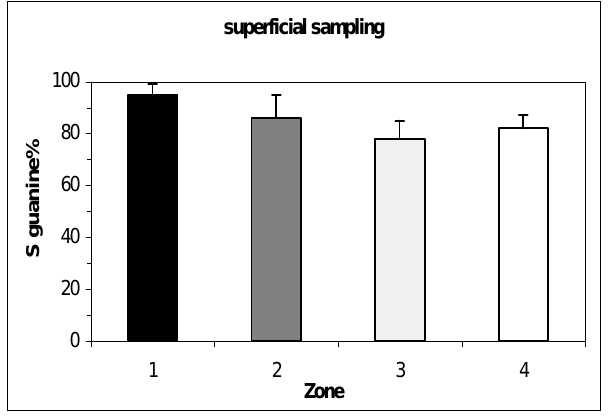
Figure 4. DNA biosensor results for superficial sampling in the four zones of hill n°5 in ACNA area (sampling of 2003). Extraction with 50 mM PBS pH 7.5, ultrasound probe 2 min. Electrochemical experimental conditions as in Figure 2.